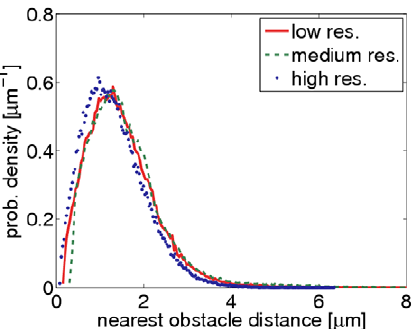
Figure 12. Test of scale invariance. The same collagen gel has been recorded with three different optical resolutions (relative voxel sizes: high/medium/low & 1/2/4). After reconstructing the three image stacks, the distribution of nearest obstacle distances were computed. The low and medium resolutions give similar results. Only at the highest resolution, the pores appear slightly smaller on average, because under these conditions even fine details of the network can be resolved.